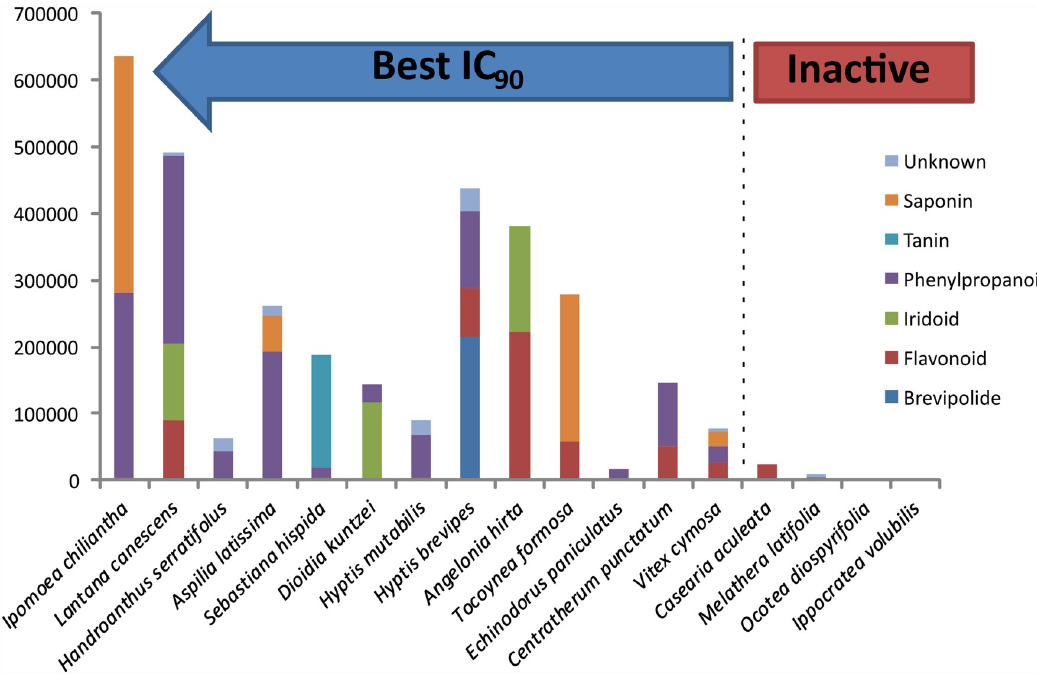
Fig 3. Chemical constitution (classes of major compounds) of ethanol extracts from 17 plant species evaluated for ovicidal action against H . placei . Plant species ordered based on ovidical activity characterized by EC 90 (calculated for active plants plotted in I_chili – V_cymos range) from right (less active) to left (more active).